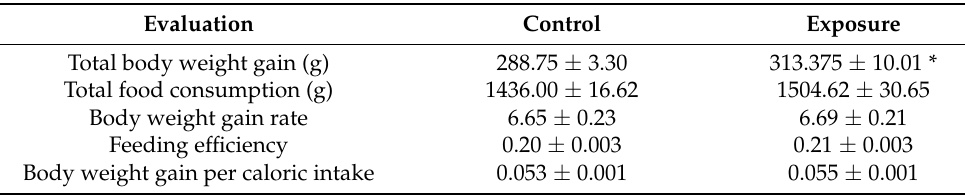
Table 1. Biometric evaluation results. Results expressed in mean ± standard error; * denotes significant difference from the control ( p < 0.05).